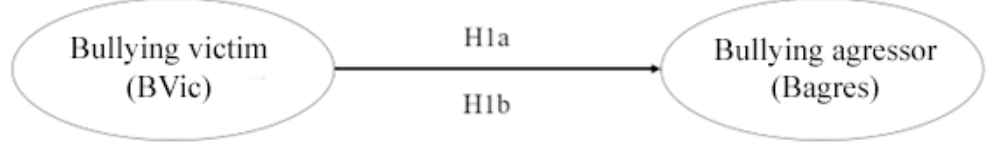
Figure 1. Proposed model.